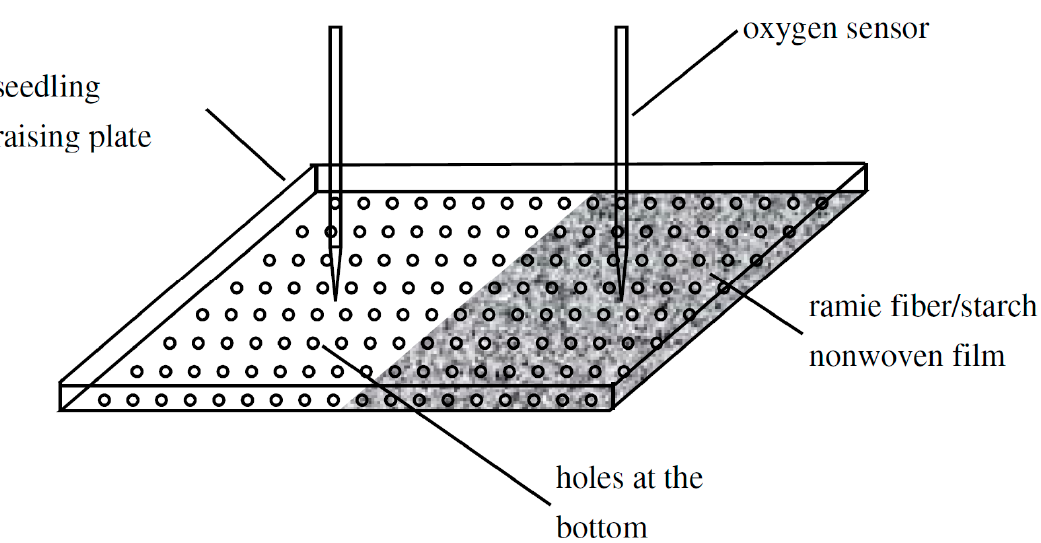
Figure 2. Diagram of the experimental device (not yet covered by seedling soil).